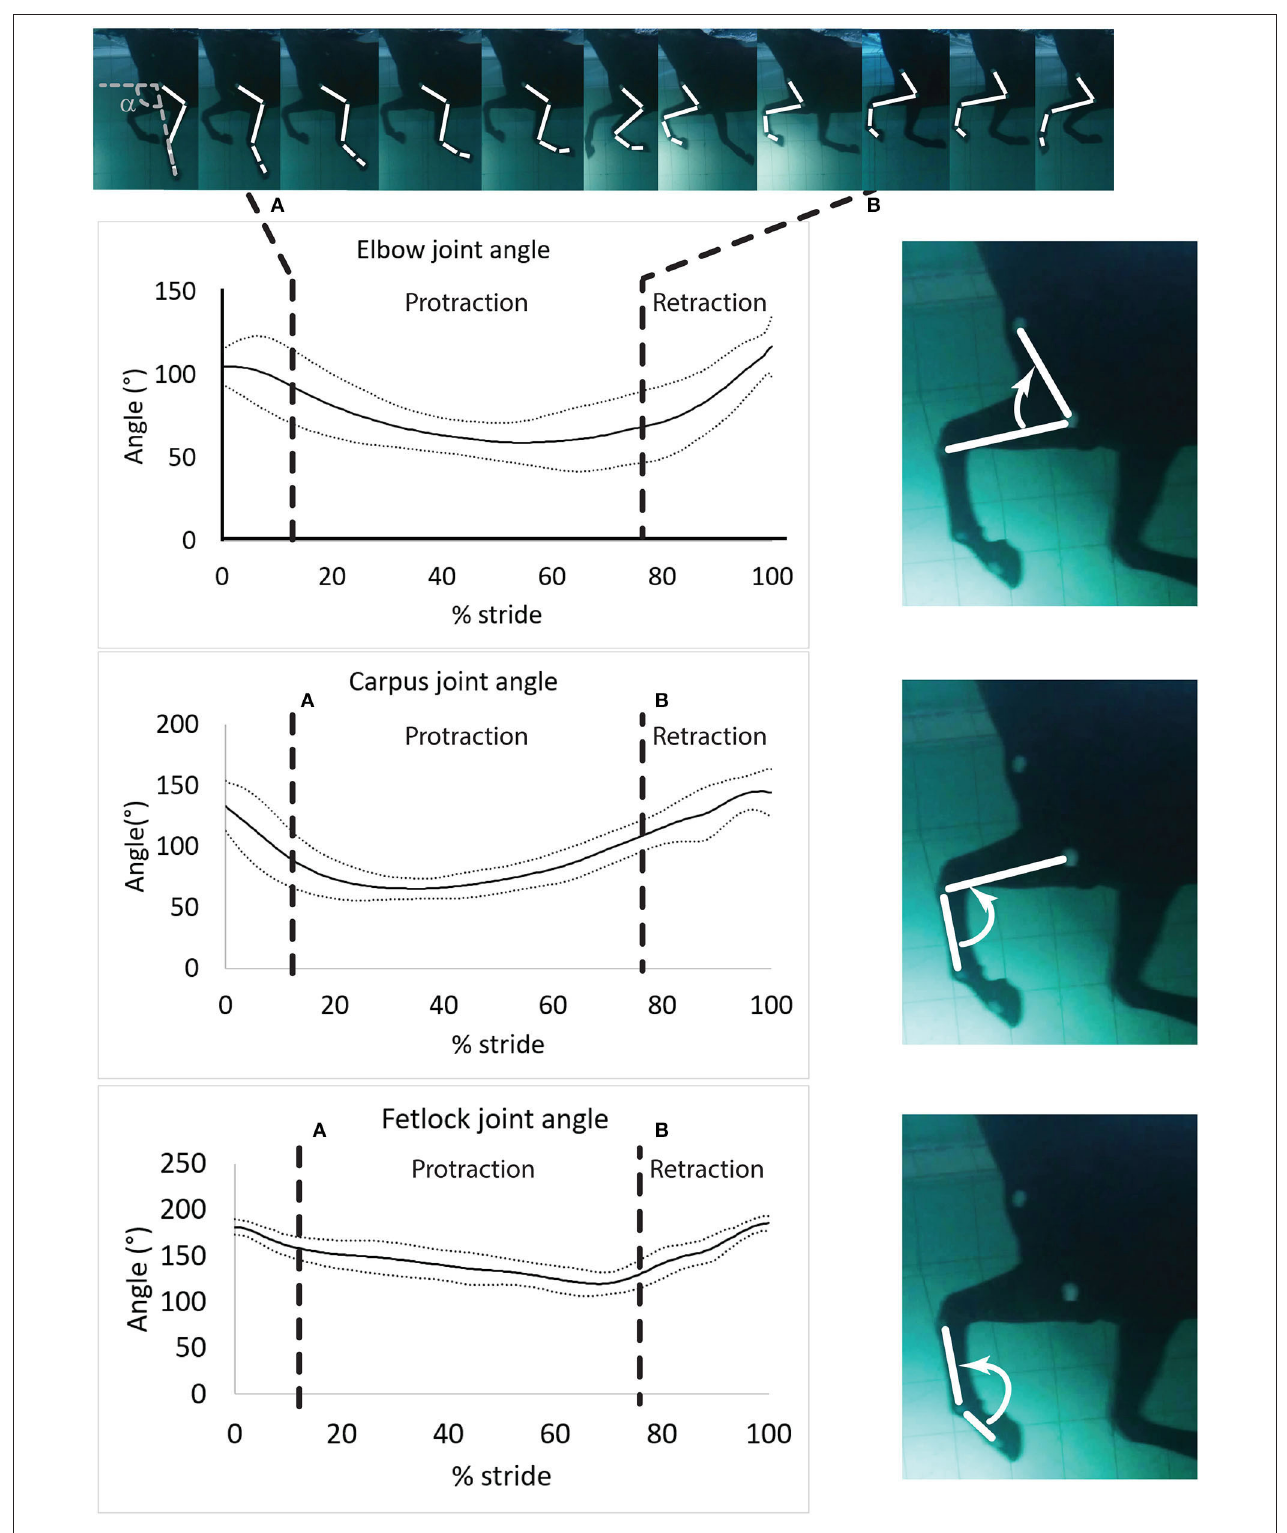
FIGURE 3 | Mean ± SD of the elbow, carpus and fetlock joint angles during a typical and complete swimming stride cycle (protraction and retraction). (A) Start of protraction phase; (B) Start of retraction phase. α : protraction-retraction angle. The arrow indicates the flexion of the joint of interest on the side illustration.